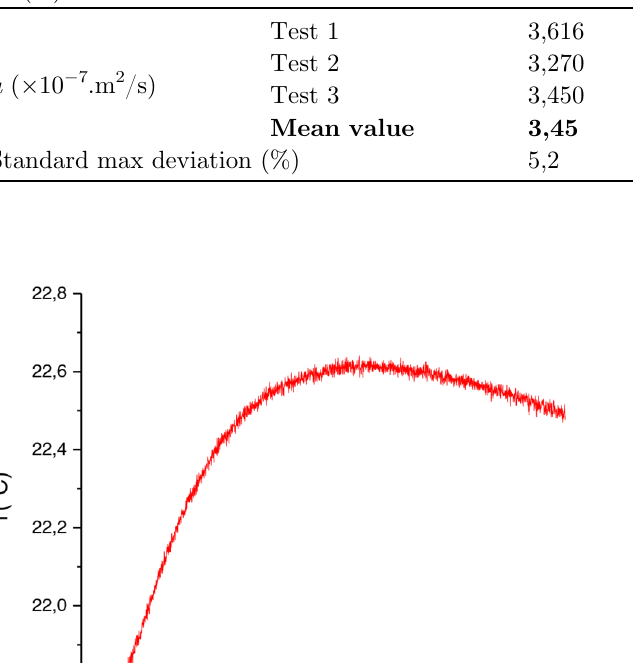
Table 2. The experimental results for thermal diffusivity of various samples. W